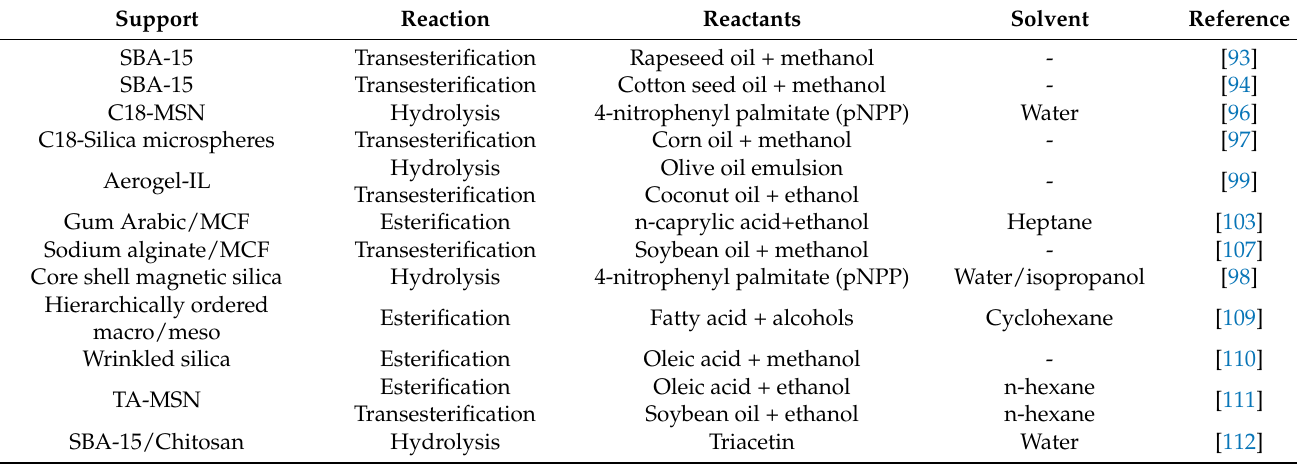
Table 3. Support used and catalyzed reactions for lipase immobilized by adsorption within mesoporous silica particles.